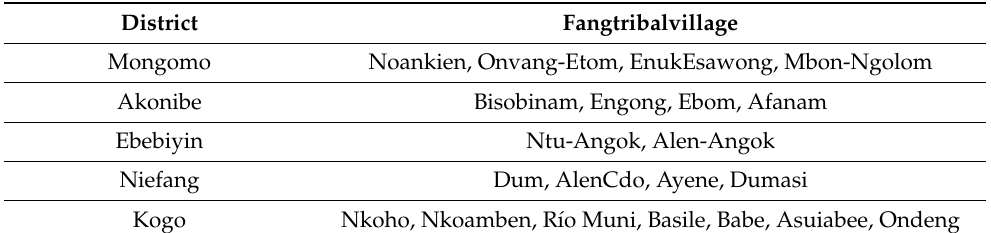
Table 3. Data collection: Fang Tribal